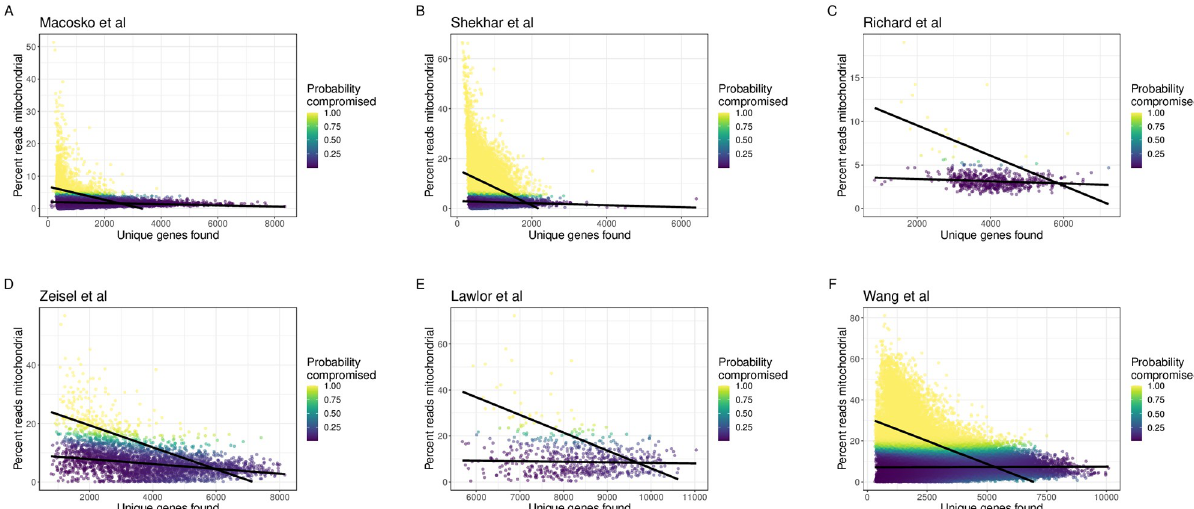
Fig 2. miQC is adaptive across species, tissues, and experimental protocols. Using publicly available scRNA-seq data from non-cancer tissues, we calculated the number of detected genes ( x -axis) and percent of cell counts mapping to mitochondrial (mtDNA) genes ( y -axis) for each cell. Black lines represent the finite mixture of linear regression models estimated from miQC to adaptively identify compromised cells across datasets. Color represents the posterior probability of a given cell being a compromised cell (yellow is a high probability and purple is a low probability). The data span both (A-D) mouse and (E-F) human scRNA-seq cells from non-cancer (A-B) retinal [30, 31], (C) immune [32], (D) brain [33], (E) pancreas [34], and (F) menstrual blood tissues [35]. In addition, the data span (A, B, F) droplet-based, (C) plate-based, and (D, E) microfluidic-based protocols.